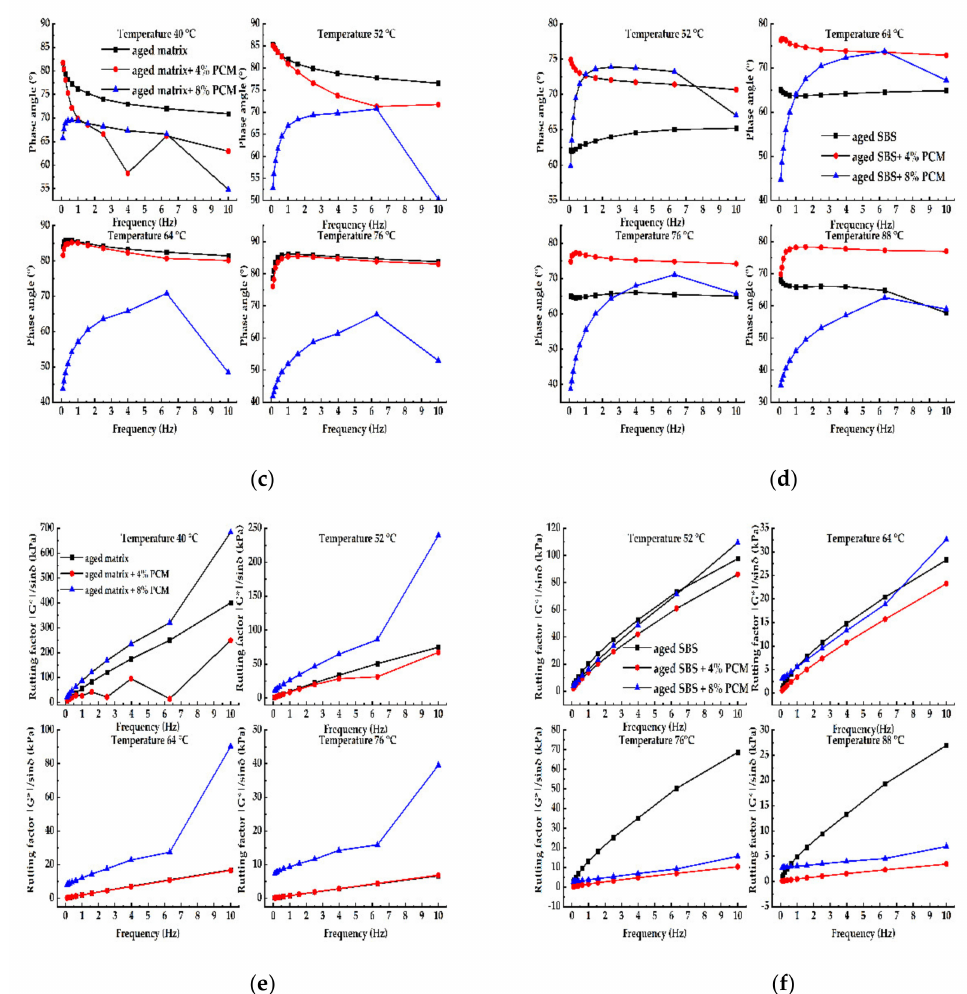
Figure 6. DSR frequency sweep test results of RTFOT aged asphalt samples with PCM under different test temperatures. ( a ) complex modulus of matrix asphalt samples; ( b ) complex modulus of SBS − modified asphalt samples; ( c ) phase angle of matrix asphalt samples; ( d ) phase angle of SBS − modified asphalt samples; ( e ) rutting factor of matrix asphalt samples; ( f ) rutting factor of SBS − modified asphalt